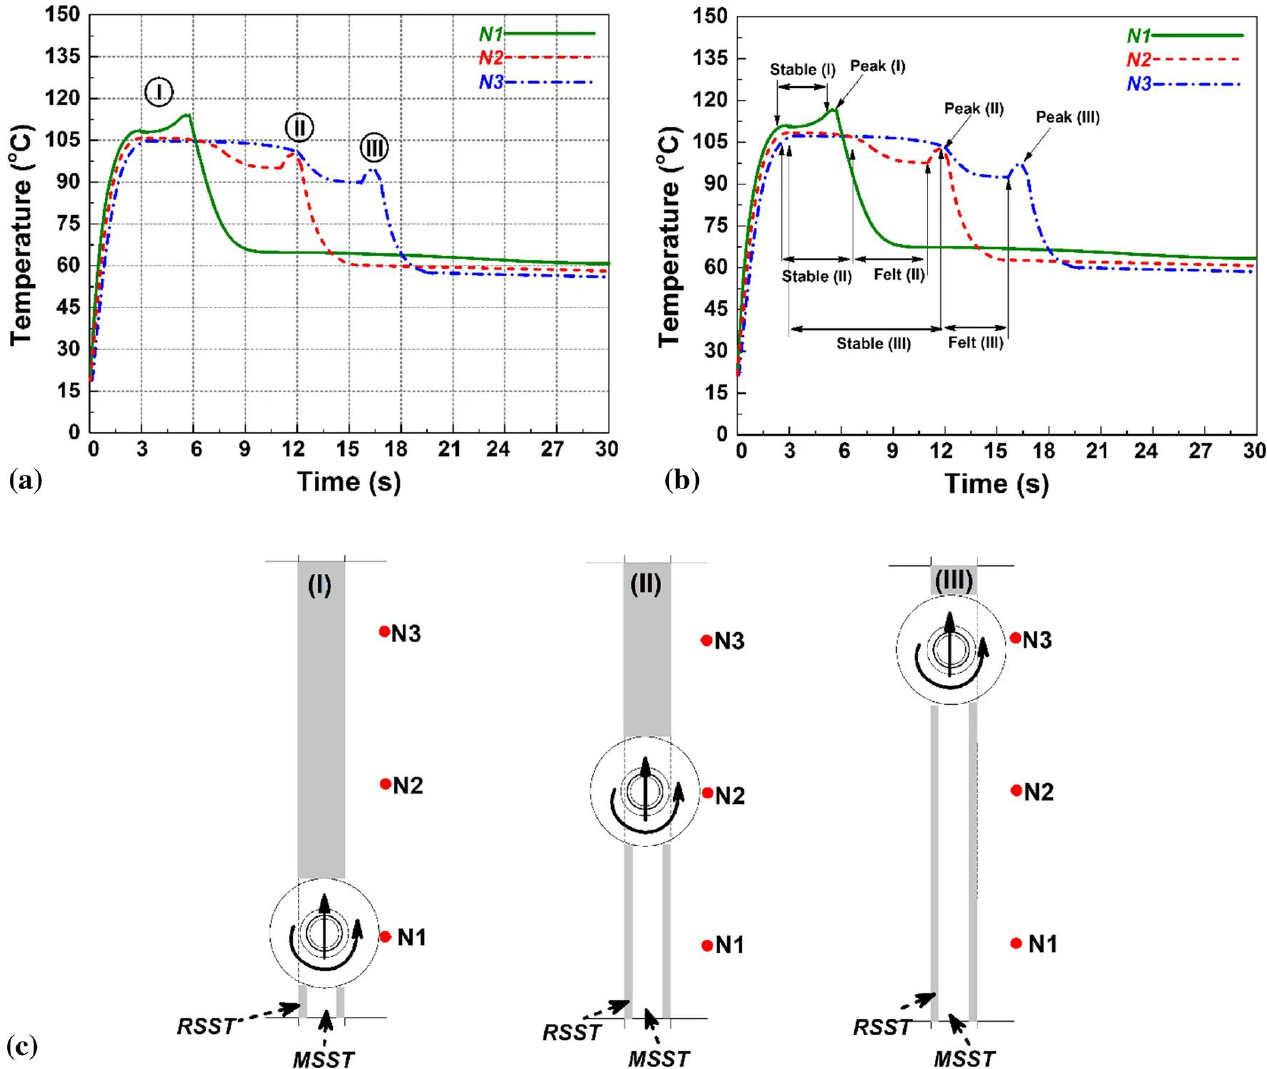
Figure 6. ( a ) Recorded temperature by different thermocouples, ( b ) different phase of thermal his- tory, ( c ) schematic view of different phase of FSJ tool in phase (I), (II), and (III) Reprinted with permission from ref. [44]. Copyright 2022 Springer Nature.